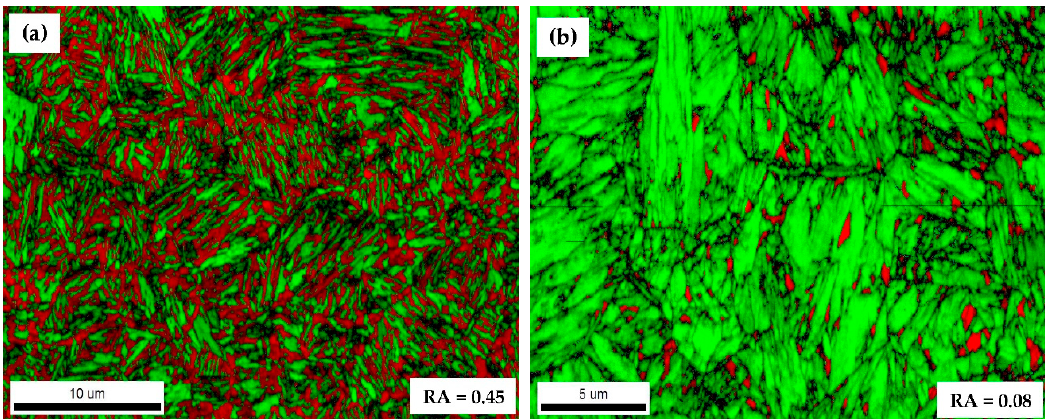
Figure 5. Electron backscatter diffraction (EBSD) phase maps showing retained austenite (RA) (red), primary martensite (green), and unidentified regions (black) in the 6Mn2Ni alloy partition-treated at ( a ) 650 °C for 500 s; ( b ) 400 °C for 300 s.